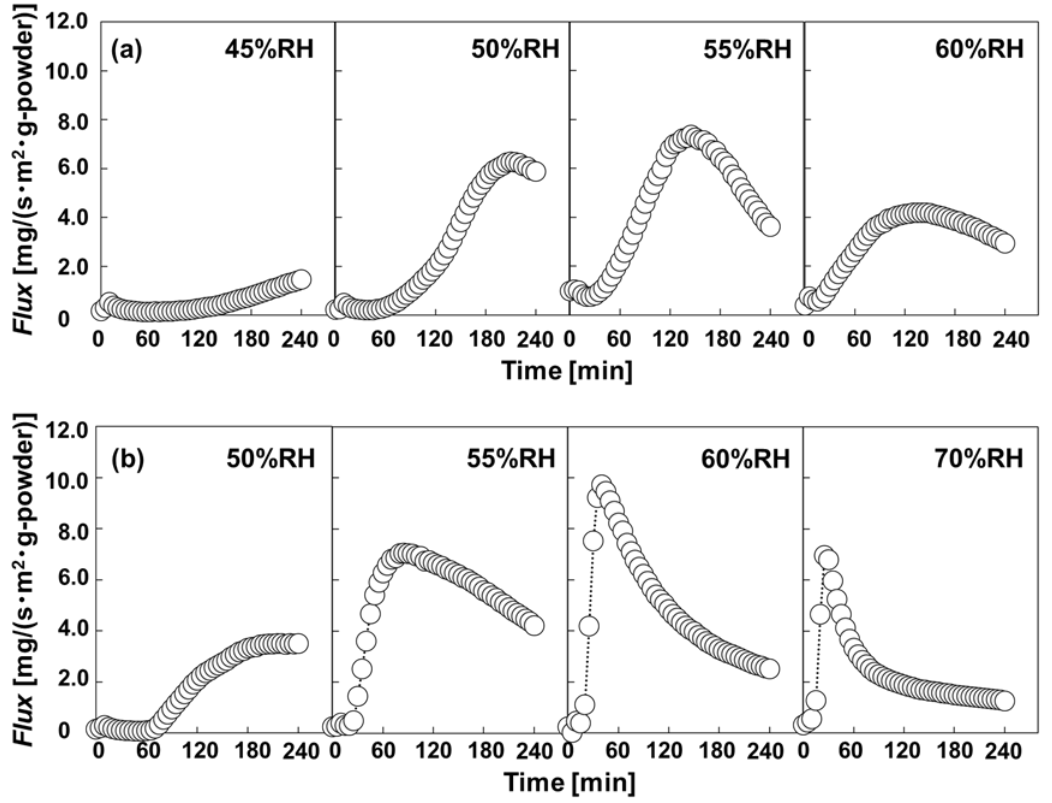
Figure 4. Release profile of d -limonene under constant humidity at 50 °C. ( a ) Suc and ( b ) Lac.